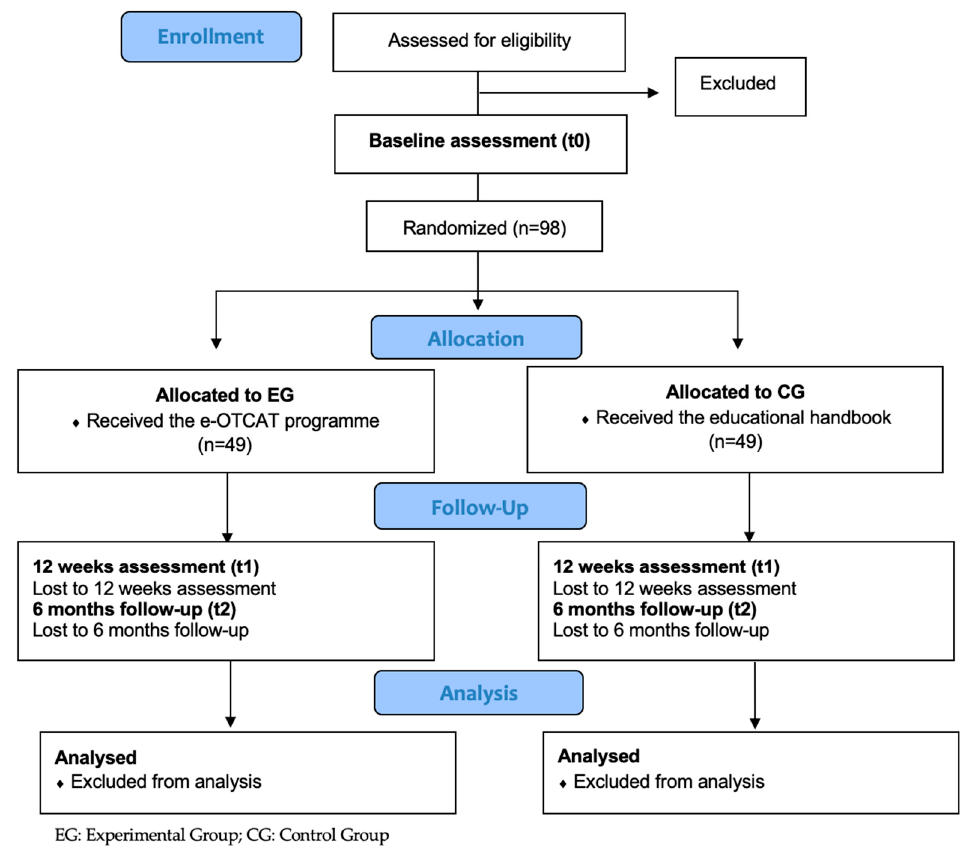
Figure 1. Flow diagram of the randomized controlled trial showing the recruitment of patients.